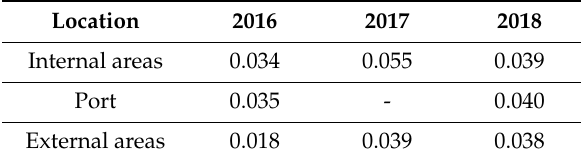
Table 3. Human Hg intake per week in the internal, port and external sampling locations assessed herein. Data are expressed as mg kg bw/week.